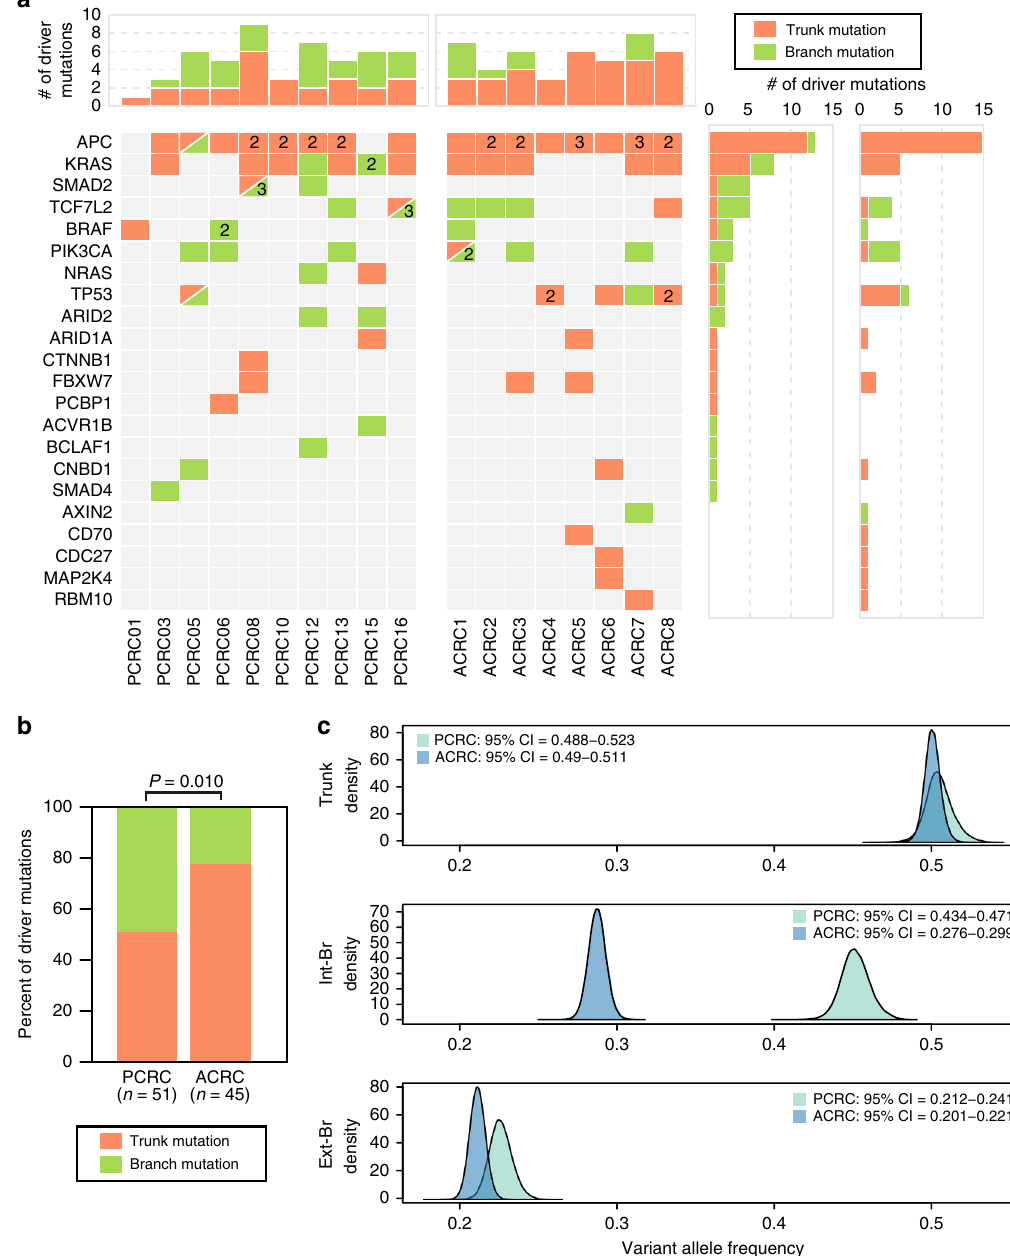
Fig. 3 Darwinian evolution mainly shapes ITH in PCRC. The multiregion mutation pro fi les of the ten PCRCs were compared with those of eight non- hypermutated ACRCs; these ACRCs in our previous study led us to conclude that ITH was mainly generated by neutral evolution. a Distribution of driver genes. Colored tables show the presence of trunk (orange) or branch (green) mutations on known driver genes in each case of the PCRCs and ACRCs. If a case had multiple driver mutations, the number is provided within the corresponding cell. Top and right bar graphs represent the sums of driver mutations for each sample and each driver gene, respectively. b Bar plots showing the proportions of trunk mutations versus branch mutations on driver mutations. Signi fi cant enrichment of branch mutations on driver genes in PCRC (25/51) was compared with ACRC (10/45; P = 0.010; Fisher ’ s exact test). c Comparison of VAFs for trunk, internal branch (int-Br), and external branch (ext-Br) mutations. Hierarchical Bayesian analysis was employed to correct the effects of tumor content and read depth as well as to remove the residuals associated with individual mutations, samples, and cases (see Methods and Supplementary Fig. 17). The density plot shows an estimated posterior distribution of the corrected mean VAFs for trunk mutations, int-Br mutations, and ext-Br mutations in PCRC or ACRC. PCRC harbored int-Br mutations with higher VAFs than ACRC. 95% CI 95% credible